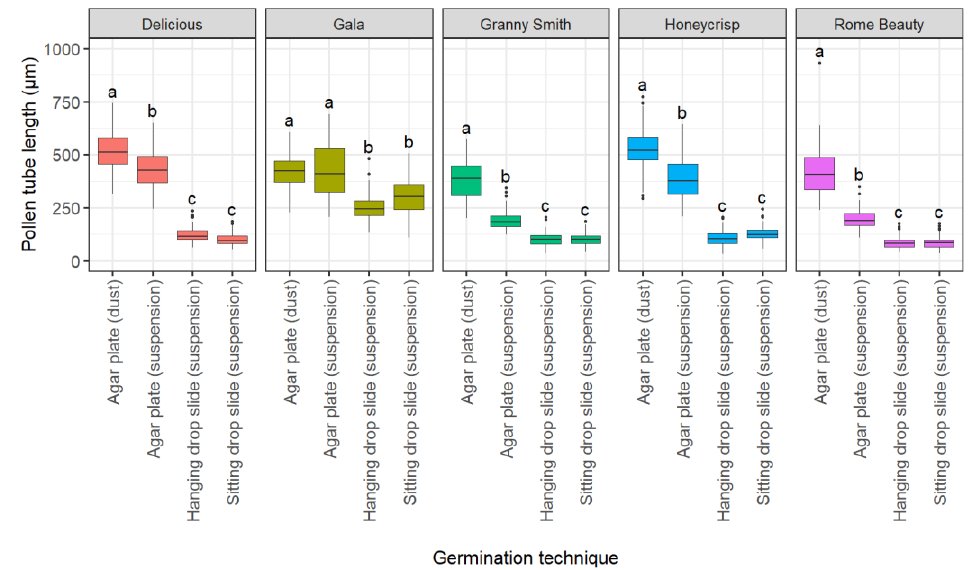
Figure 2. Effect of germination media on in vitro pollen tube length of ‘Delicious’, ‘Gala’, ‘Granny Smith’, ‘Honeycrisp’, and ‘Rome Beauty’. Different letters indicate significant differences among germination media within cultivars based on Fischer’s LSD test ( p < 0.05).